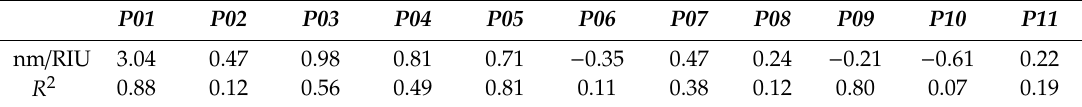
Table 1. Sensitivities of the di ff erent Bragg reflection peaks to applied SRI.